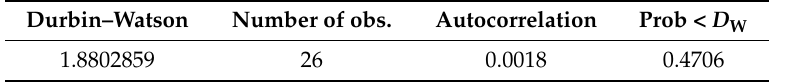
Table 7. Residue autocorrelation testing as a demonstration for the sample density J A = 5 A · dm − 2